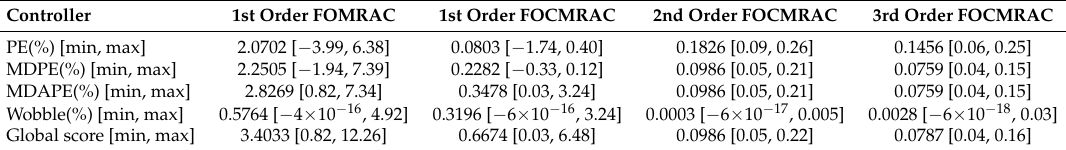
Table 3. Overall performance characteristics for the fractional-order adaptive controllers applied to 30 virtual patients. The values are reported as mean values and the minimum and maximum values within the 30 patients are